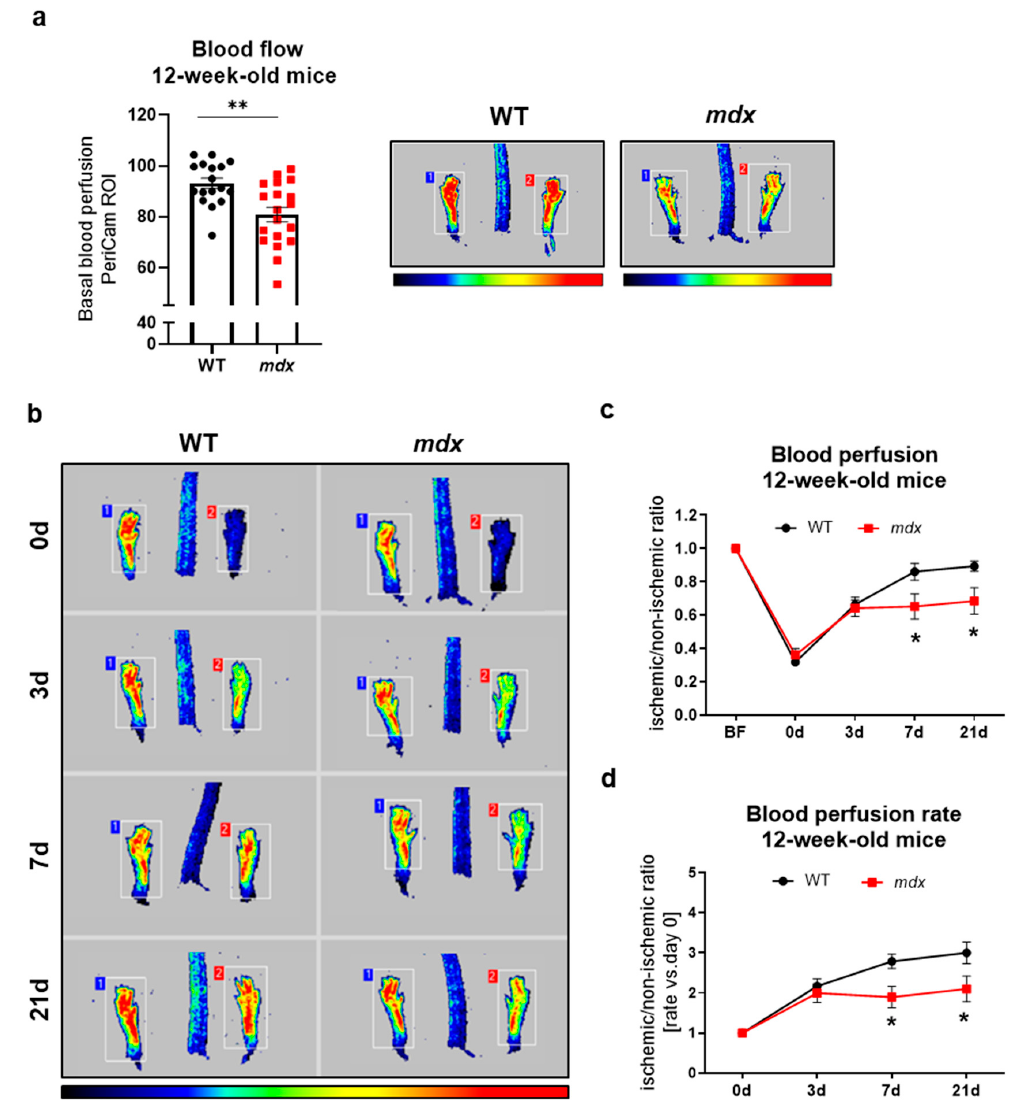
Figure 5. Decreased revascularization in 12-week-old mdx mice following hindlimb ischemia (HLI). ( a ) Under basal conditions, hindlimb blood flow is lower in dystrophic animals; PeriCam measurement; region of interest (ROI); n = 17–19/group. ( b ) The recovery of blood flow is impaired in mdx mice both 7 days and 21 days after the HLI procedure as shown by representative pictures and a calculation of ( c ) blood perfusion and ( d ) blood perfusion rate; n = 11–14/group. The results are presented as mean ± SEM. * p < 0.05, ** p < 0.01 with ( a ) unpaired two-tailed Student’s t -test or ( c – d ) with two-way ANOVA with Tukey’s posthoc test.